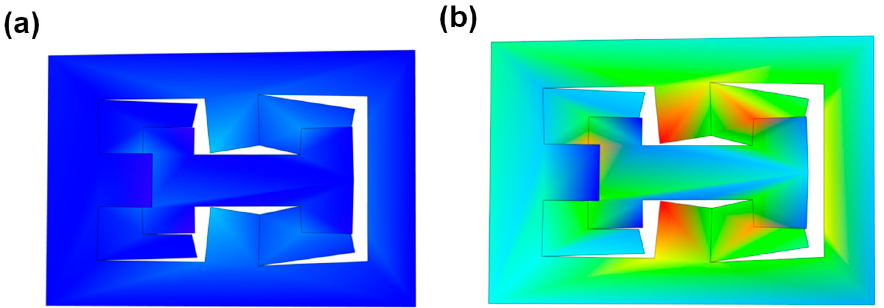
Figure 9. Top view strain visualization of SLEM structure with different maximum strain percentage values. The remaining parameters are kept constant at their maximum values: axial stiffness, fold stiffness, facet crease stiffness, damping ratio. Maximum strain allowed: ( a ) 5%, ( b ) 1%. Reducing maximum strain displays the strain distribution more clearly. Strain visualization allows us to see the high-stress/strain points to predict failure points. The red or orange areas are more likely to fail first due to wear and tear after repeated movements.